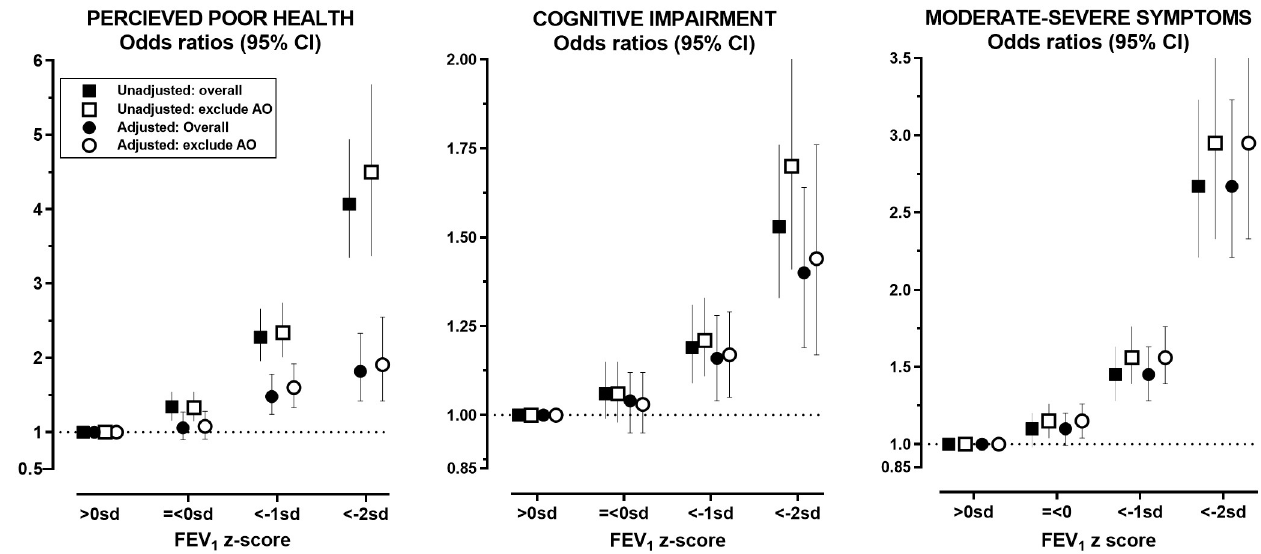
Fig 1. Unadjusted and aORs (95% CI) for self-reported perceived poor health status, respiratory symptoms, and low cognitive scores by grades of low FEV 1 relative to reference group in the overall cohort and in participants without spirometry AO. AO, airflow obstruction; aOR, adjusted odds ratio; FEV 1 , forced expiratory volume in 1 second; SD, standard